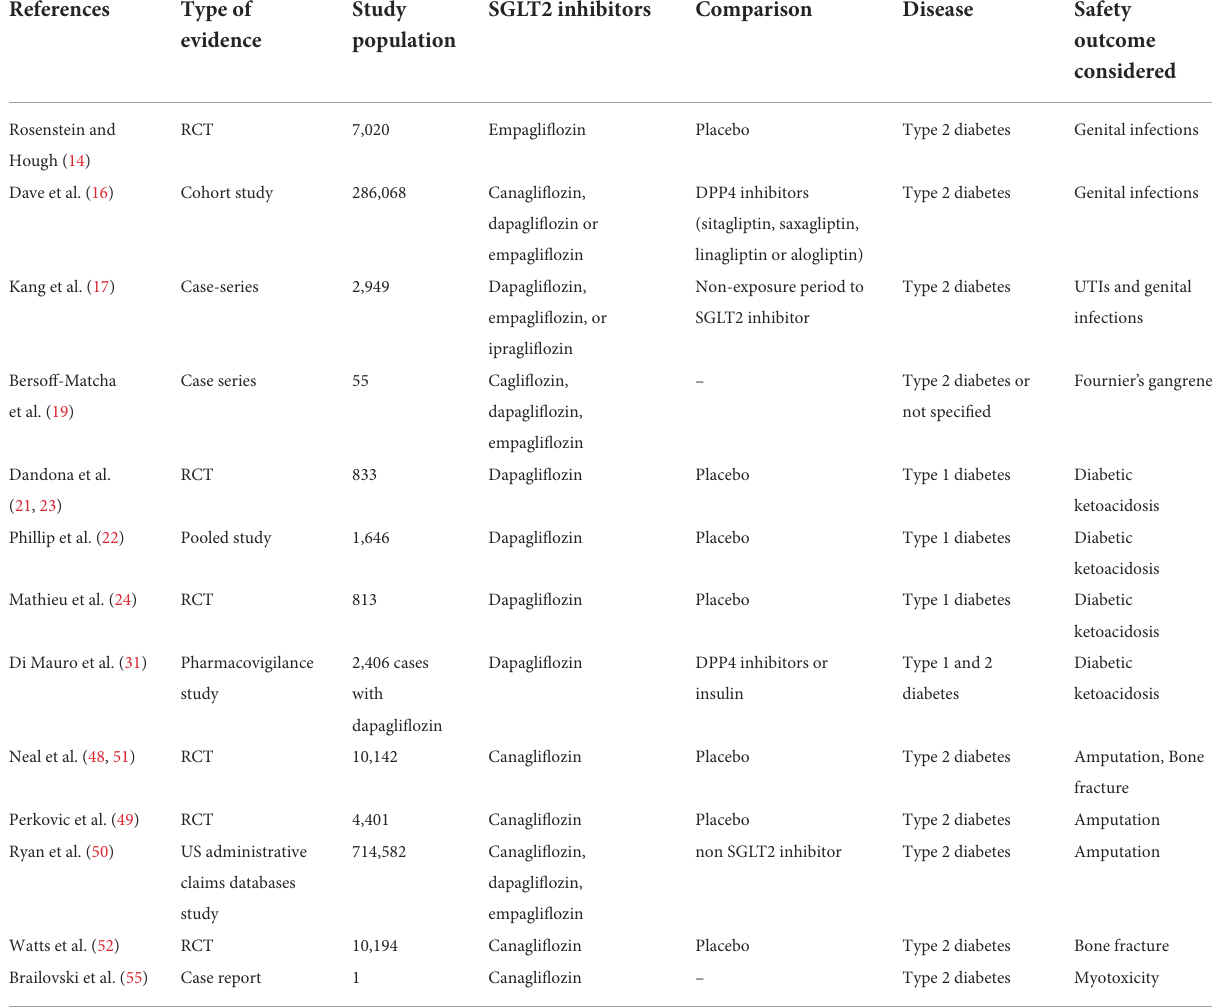
TABLE 2 Characteristics of safety clinical